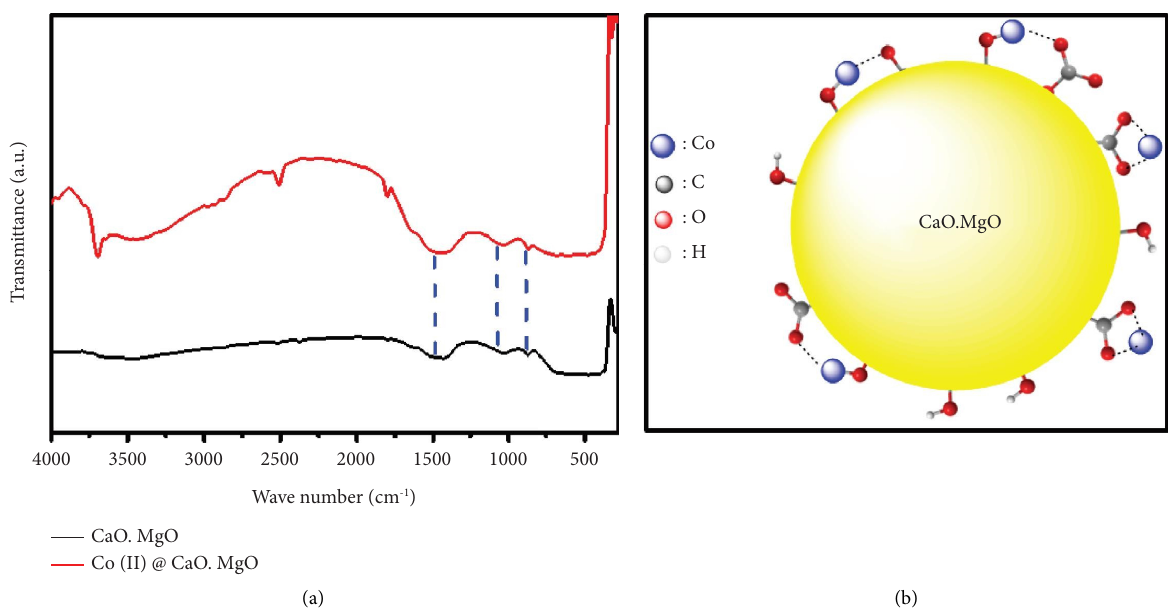
Figure 8: FTIR spectra of CaO.MgO nanosorbent before (a) and after Co (II) adsorption and (b) the proposed adsorption